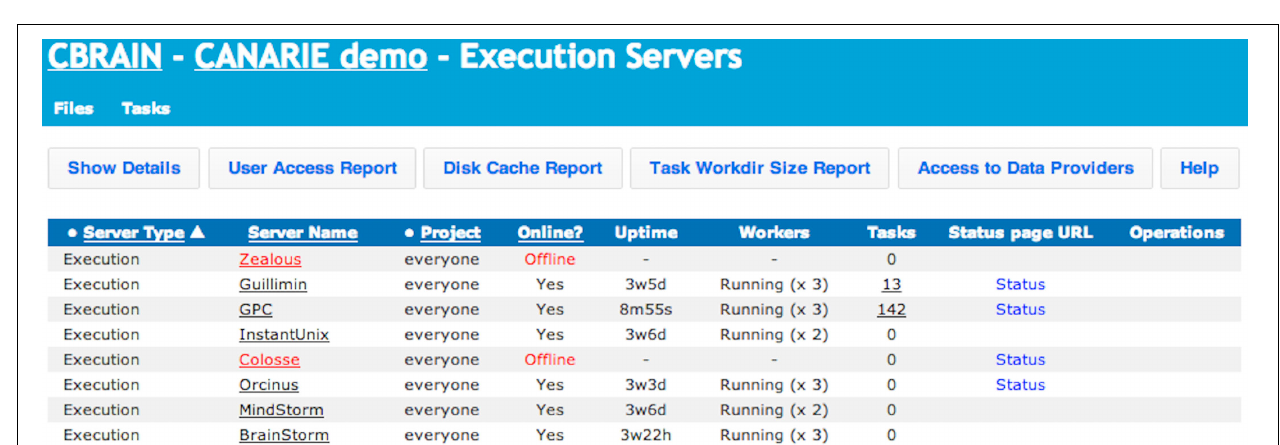
cores per node (Parallel CIVET x8), Guillimin has the same type of scheduling, but with 12 cores per node (Parallel CIVET x12), while Mammouth-S provides per core scheduling. Although the user has full control of the tasks across the various sites, this is completely optional and transparent. Once jobs are completed, results are automatically transferred to the selected project.